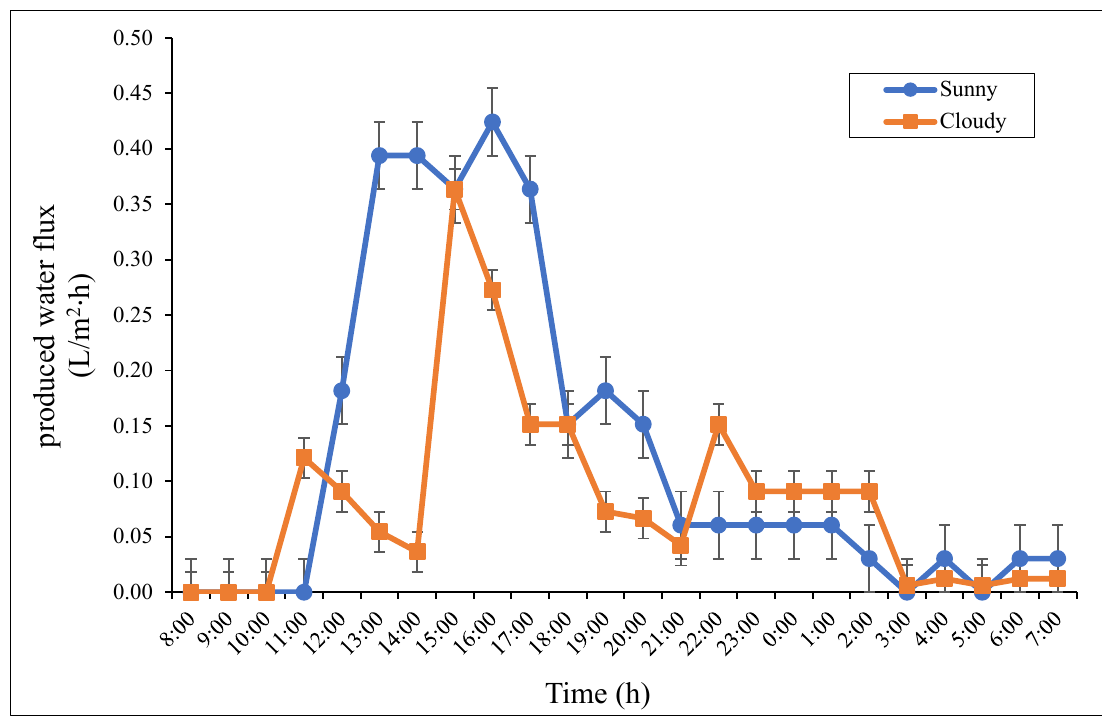
Figure 9. Effects of atmospheric conditions on the water production rate.